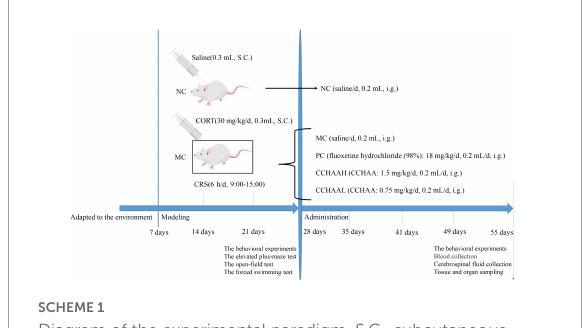
SCHEME1 Diagram of the experimental paradigm. S.C., subcutaneous injection; i.g., intragastric